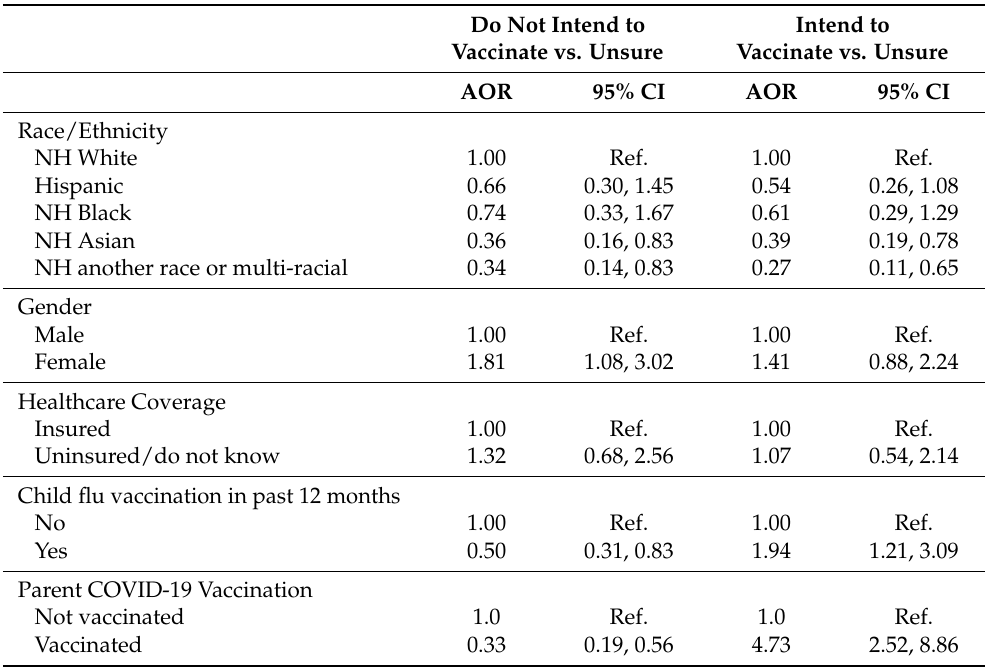
Do Not Intend to Vaccinate vs.